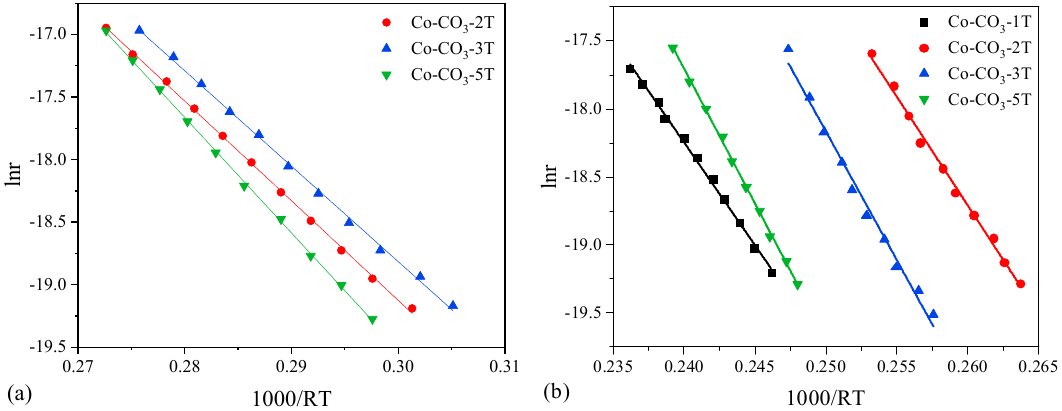
Figure 8. Arrhenius plots of lnr vs. 1000/RT for ( a ) propane oxidation and ( b ) toluene oxidation.